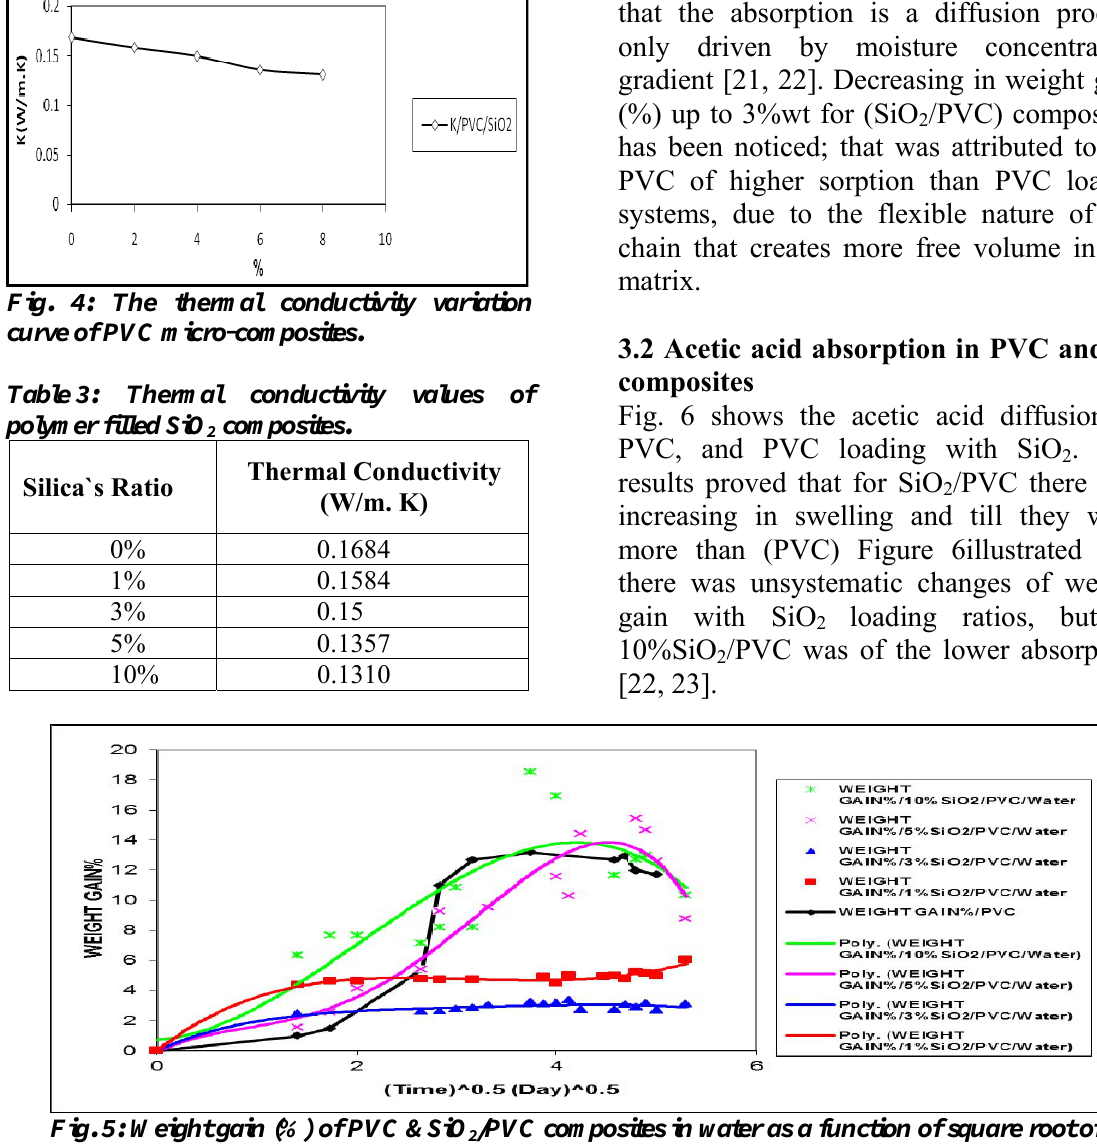
Fig. 5: Weight gain (%) of PVC &SiO